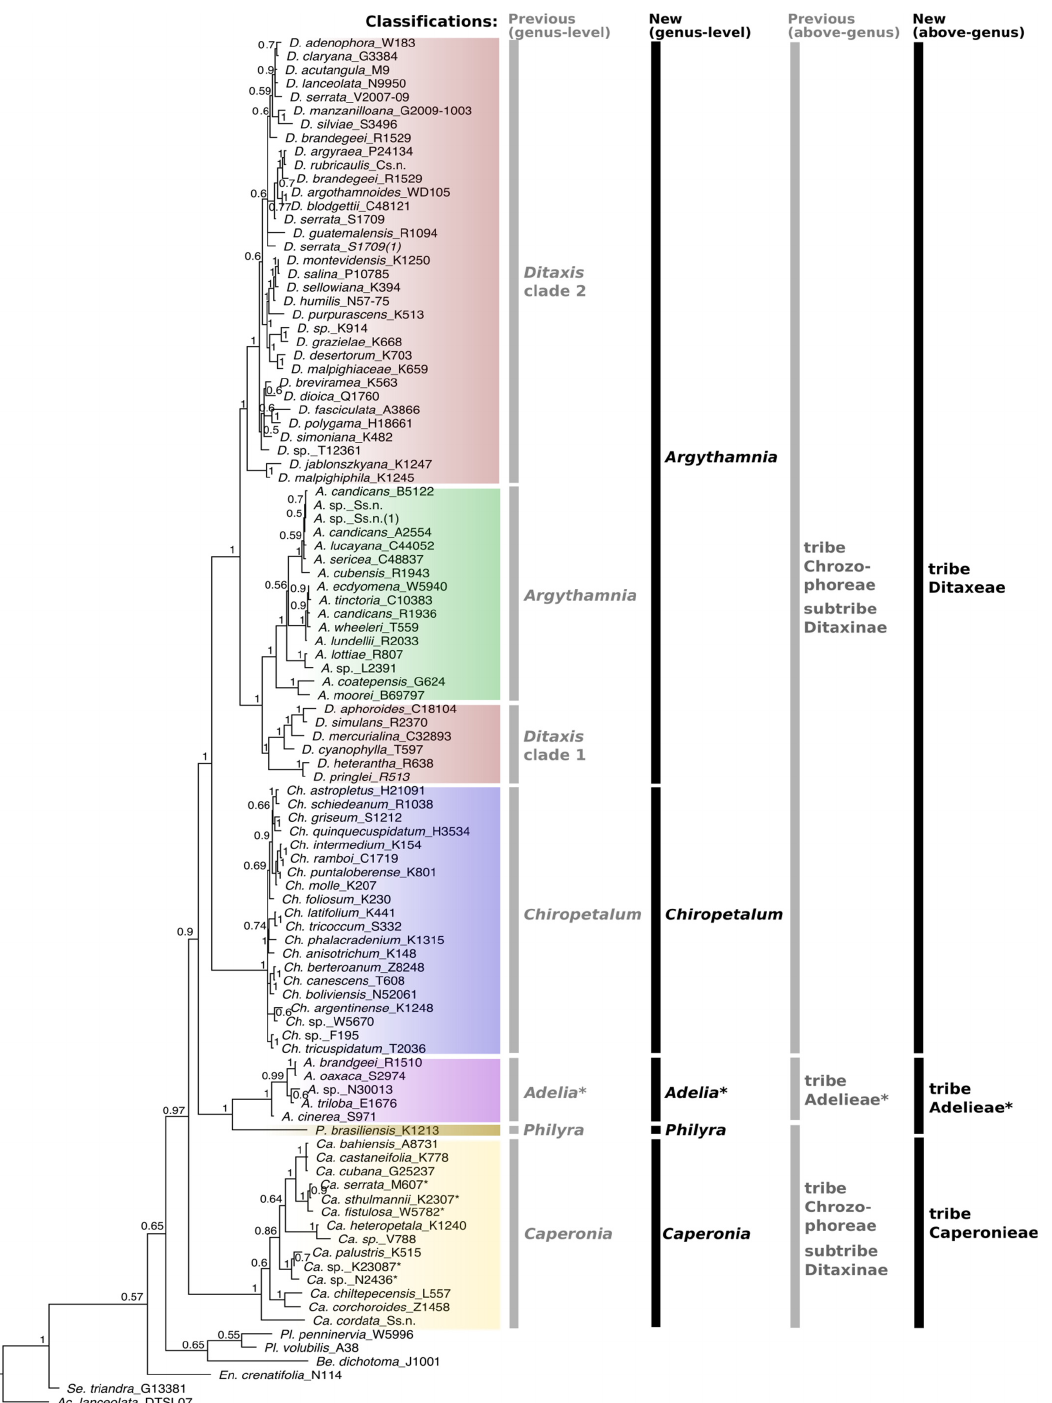
Figure 1. Majority rule consensus tree of Ditaxinae (Euphorbiaceae) and related taxa based on the combined five markers (cpDNA [ trn LF, trn TL, pet D] and nDNA [ETS, ITS]) obtained through Bayesian inference. Bayesian posterior probabilities (PPs) are indicated on each branch. Vertical bars with labels on the right indicate the old (gray) [5] and the new (black) generic and suprageneric classifications. Asterisks in Adelia and Adelieae indicate that this clade is not fully represented here (several unsampled genera); we followed the classification proposed by Jestrow [29] (based on a complete generic sampling of Adelieae). To avoid confusion, some genera are abbreviated using two initial letters: Ac. = Acalypha , Be. = Bernardia , Ca. = Caperonia , Ch. = Chiropetalum , En. = Enriquebeltrania , Pl. = Plukeneria , Se. = Seidelia